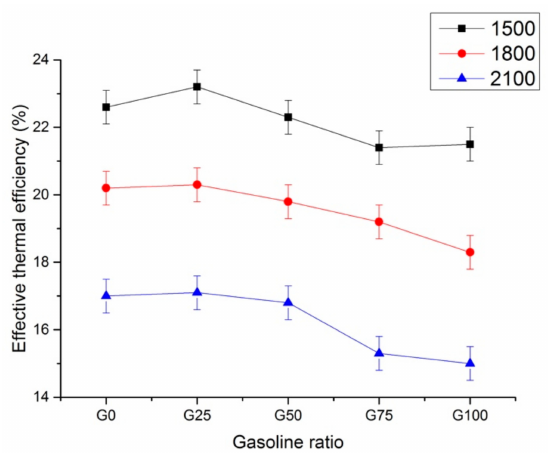
Figure 4. E ff ective thermal e ffi ciency with R e for di ff erent speed (The direct injection timing is 180 ◦ CA BTDC. The ignition timing is MBT. The intake manifold absolute pressure is 42 kPa).